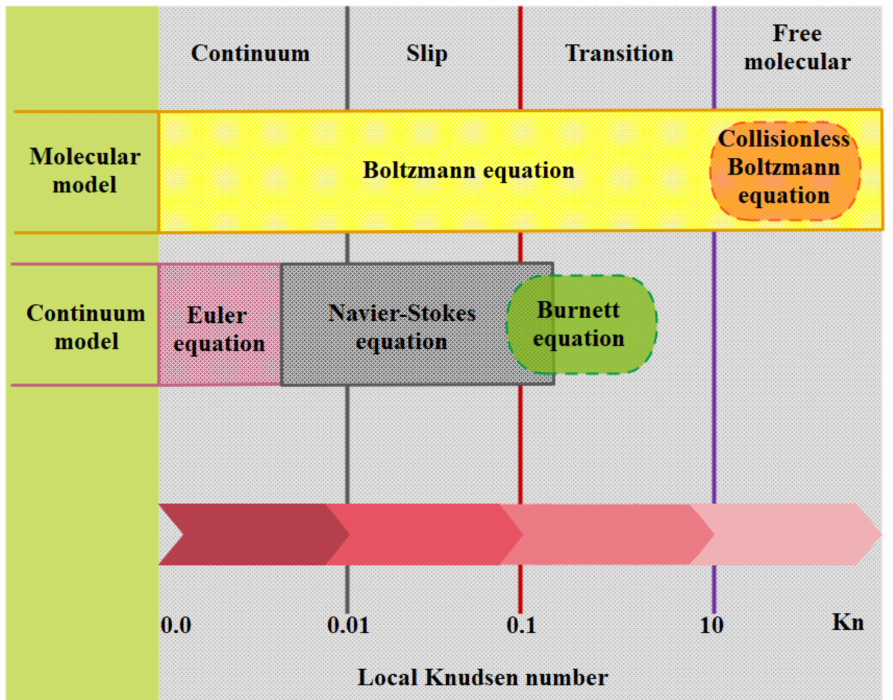
Figure 9. Modeling approaches and correlations of different flow